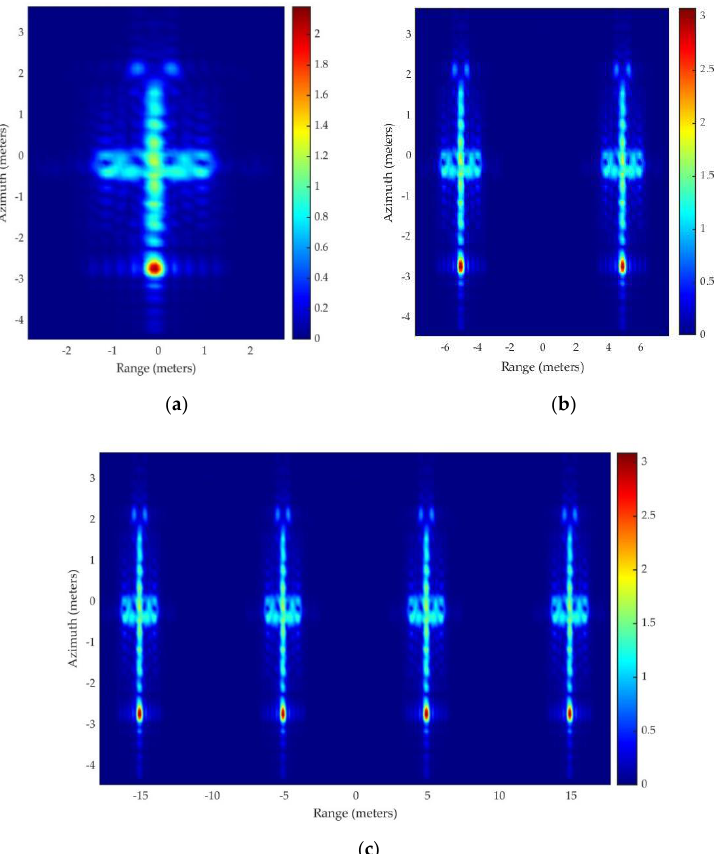
Figure 9. SAR images of missile−like targets in the free space: ( a ) one target; ( b ) two targets; ( c ) four targets.